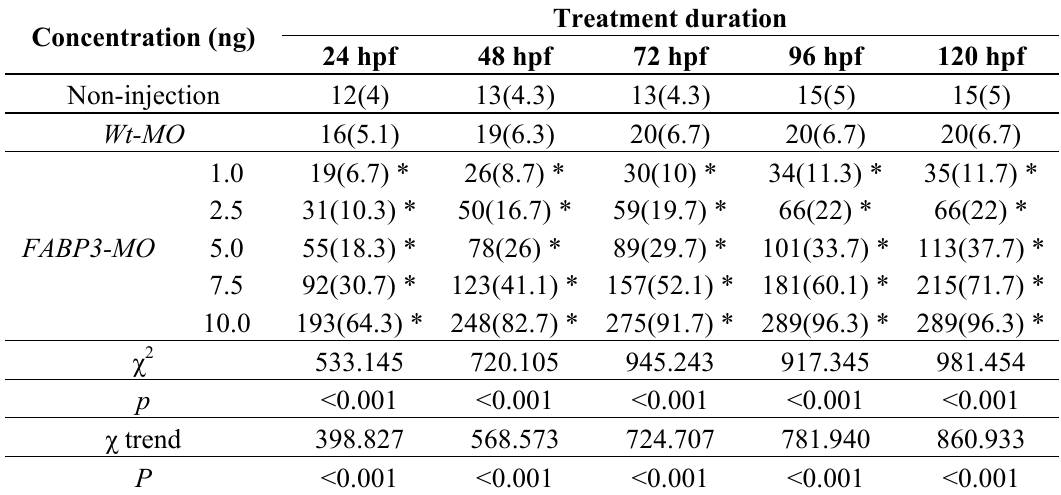
Table 1. The mortality rate of zebrafish embryos injected with